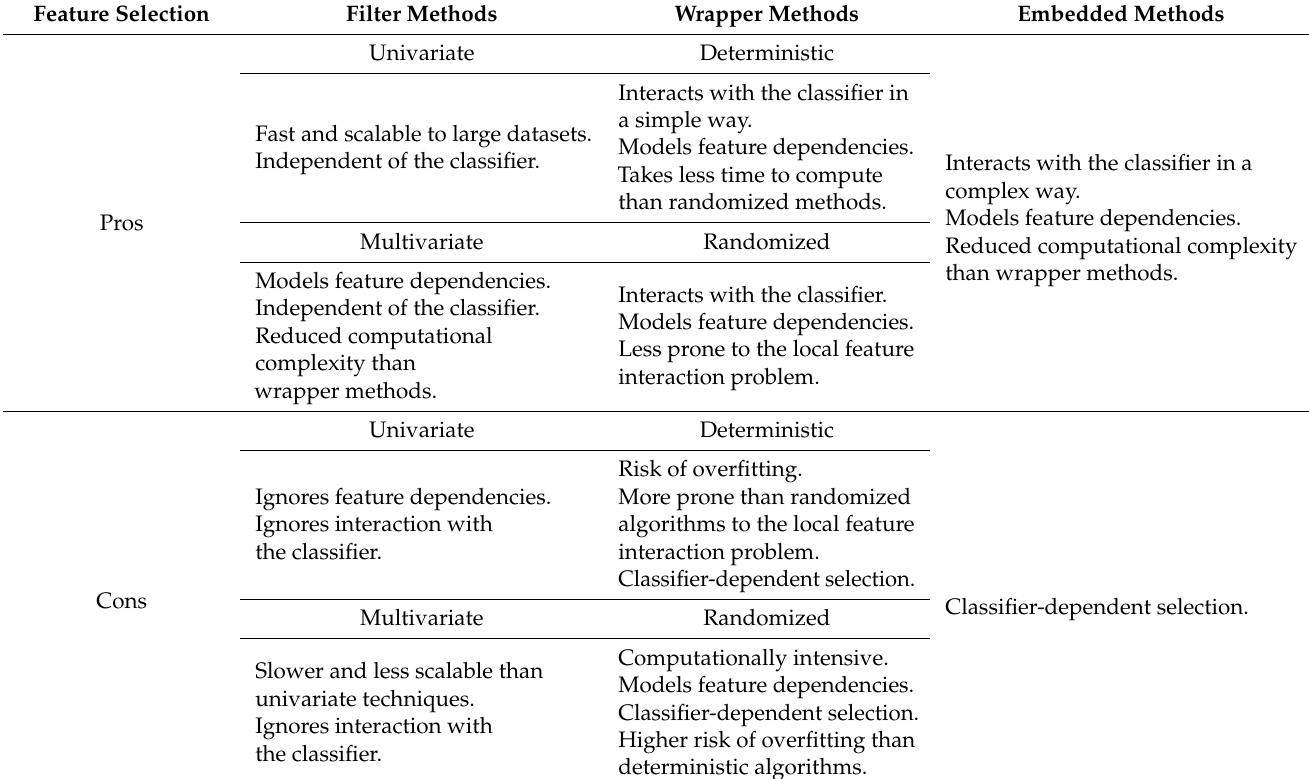
Table 5. Characteristics of the categories of feature engineering methods for gene expression